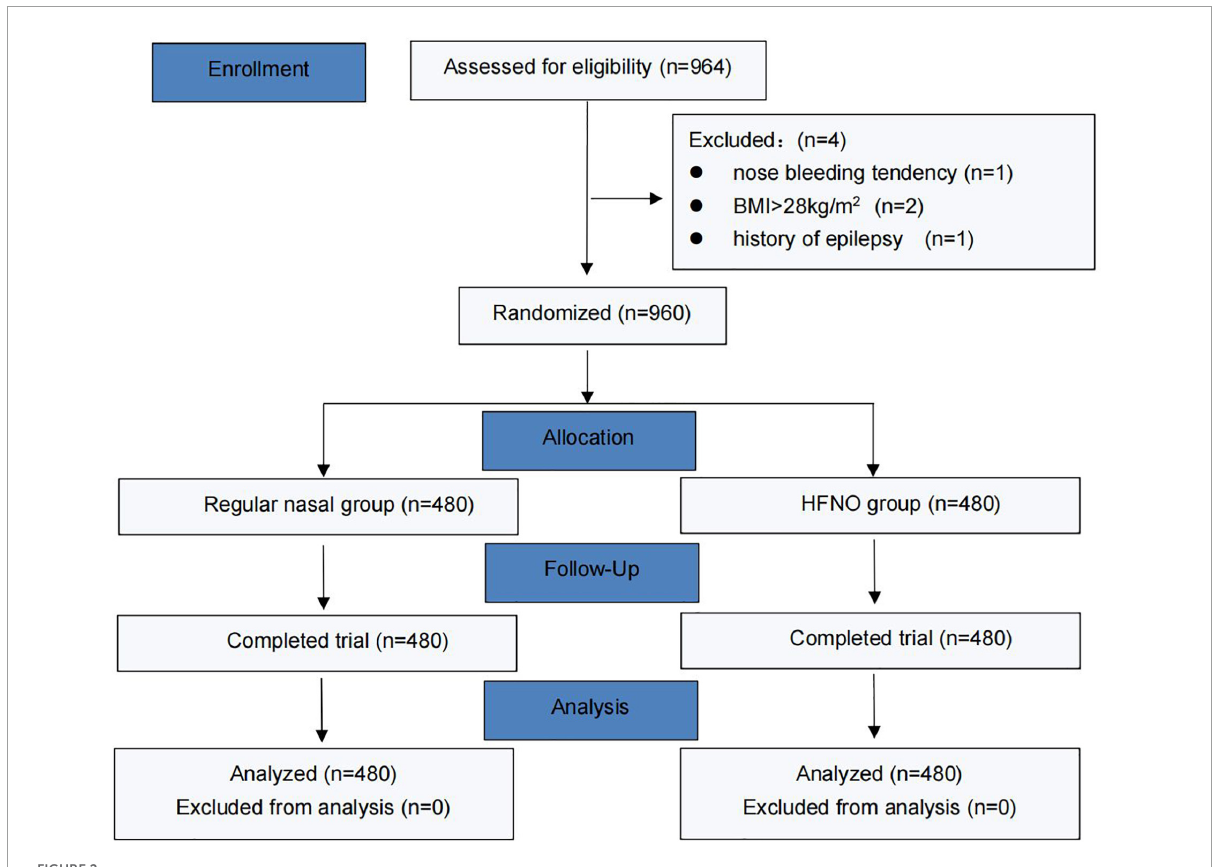
FIGURE2 CONSORT flowchart of study. HFNO, high-flow nasal oxygen.